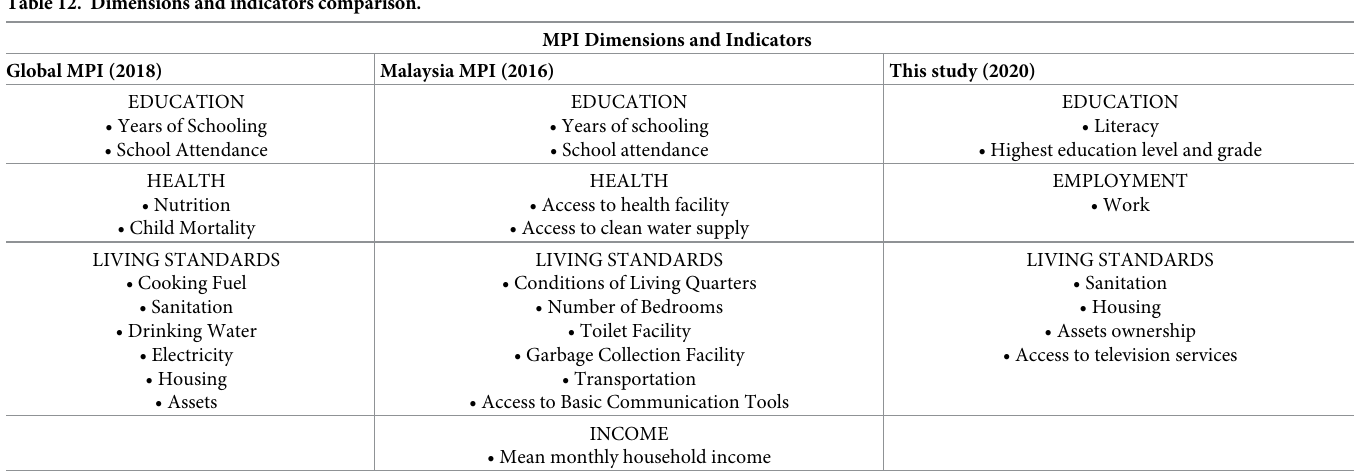
Table 12. Dimensions and indicators comparison.